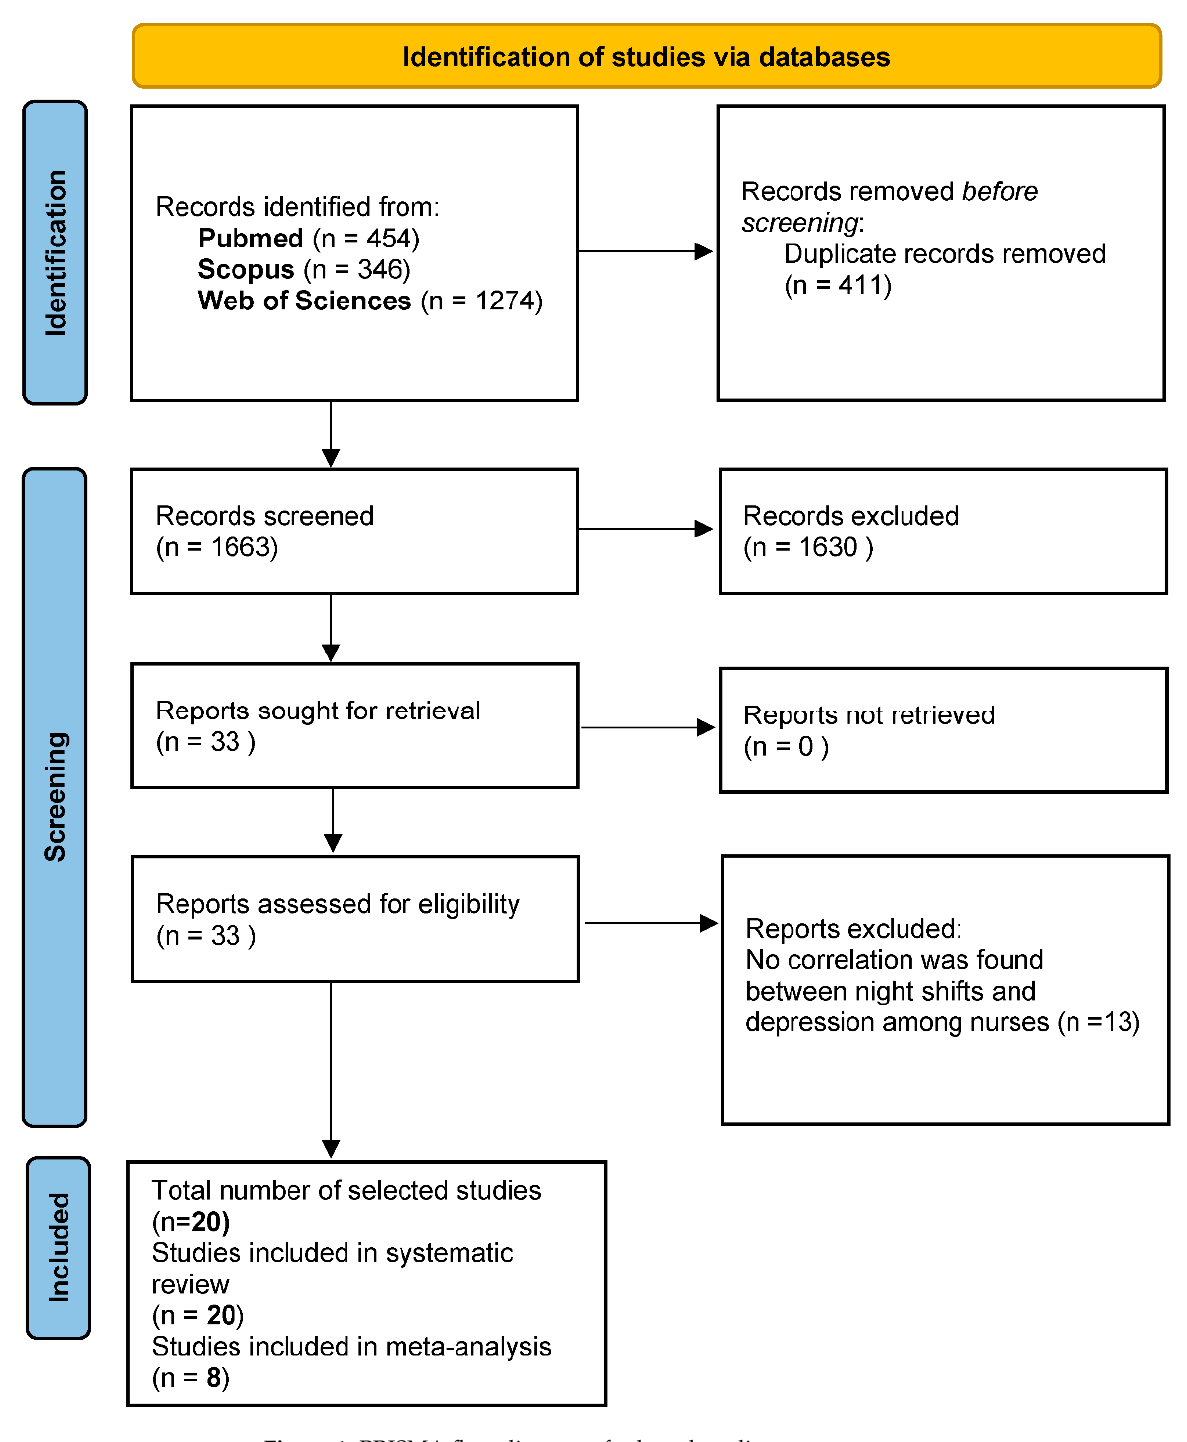
Figure 1. PRISMA flow diagram of selected studies.